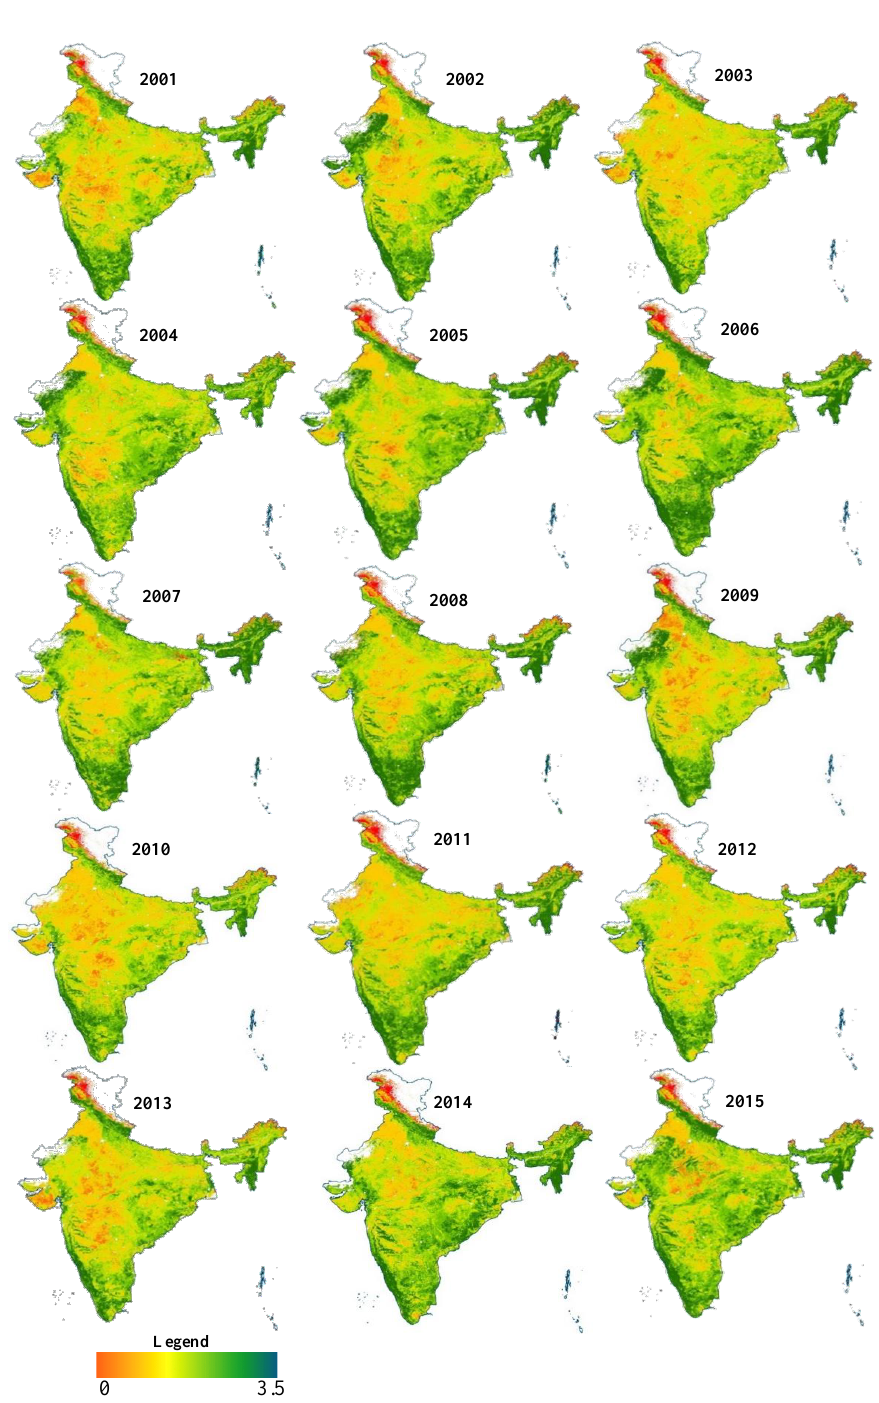
Figure 4. Seasonal dynamic habitat index (DHI-sea) is the ratio between mean and standard deviation of monthly FAPAR for a particular year was utilized to map the seasonal greenness variability from 2001 to 2015. The DHIs composite illustrate the relative importance of each component at pixel level during 2001–2015. The pallet assigned to cyan color observed across Northeast, Western Ghats, and western Himalaya represents higher DHI-cum and DHI-min values and lower DHI-sea (Figure 5). The DHIs composite with reddish-brown color in the arid and semi- arid exhibits high DHI-Cum and DHI-sea, while low DHI-min. The greenish brown